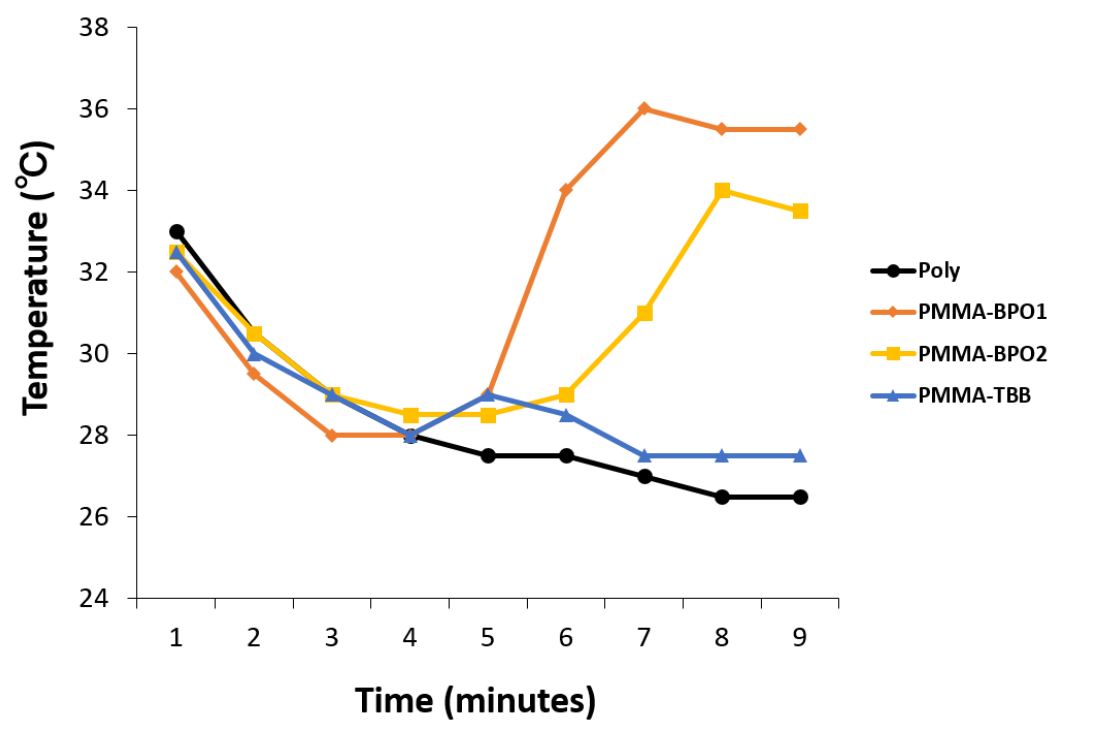
Figure 5. Temperature changes of the three different materials during polymerization. The measurement was continued until the temperature reached a peak in all materials. The hydrophilic / hydrophobic state was evaluated on the three materials by measuring the contact ◦ angle of 10 µ L ddH 2 O placed on the material surfaces. The contact angle was greater than 60 C on the PMMA-BPO cements, indicating that the surfaces were hydrophobic (defined as a contact angle of ◦ ◦ 45 C or higher), whereas it was approximately 35 C on the PMMA-TBB cements, indicating that the surface was hydrophilic (Figure